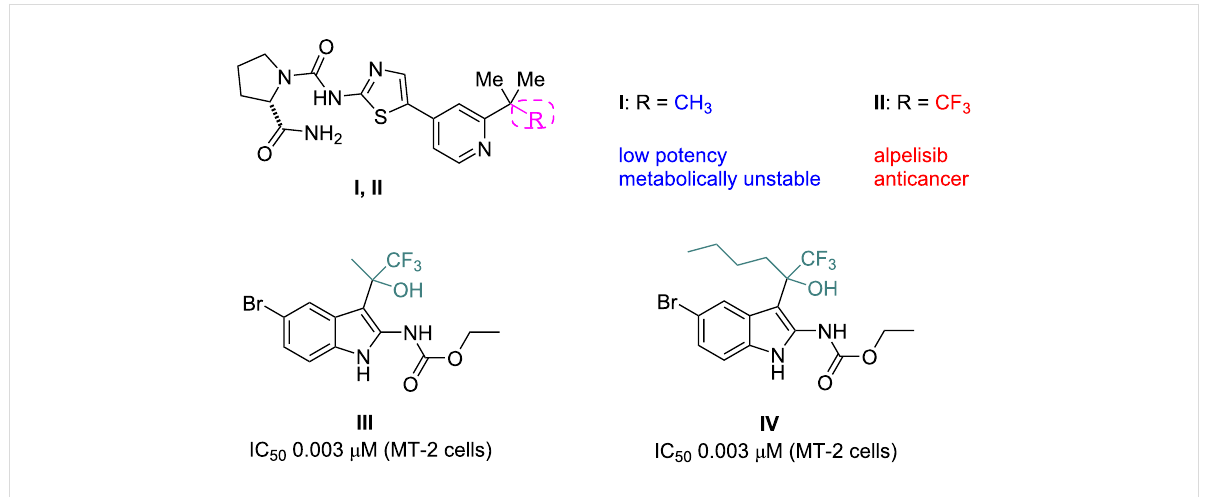
Figure 1: Structures of trifluoromethylated compounds and their biological